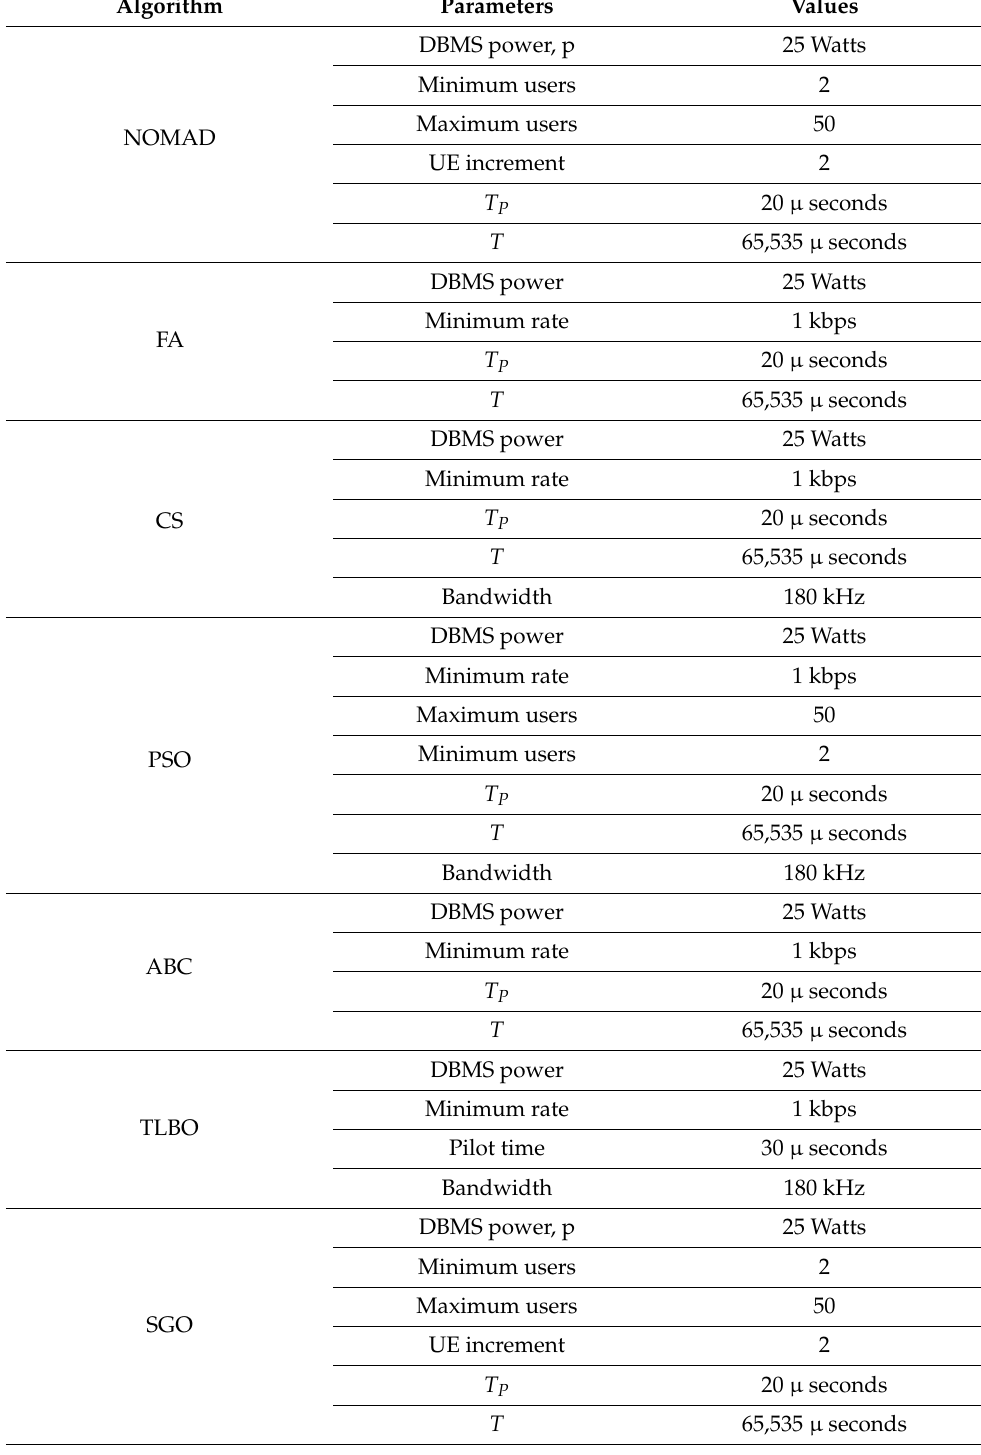
Table A1. Simulation parameters of the other